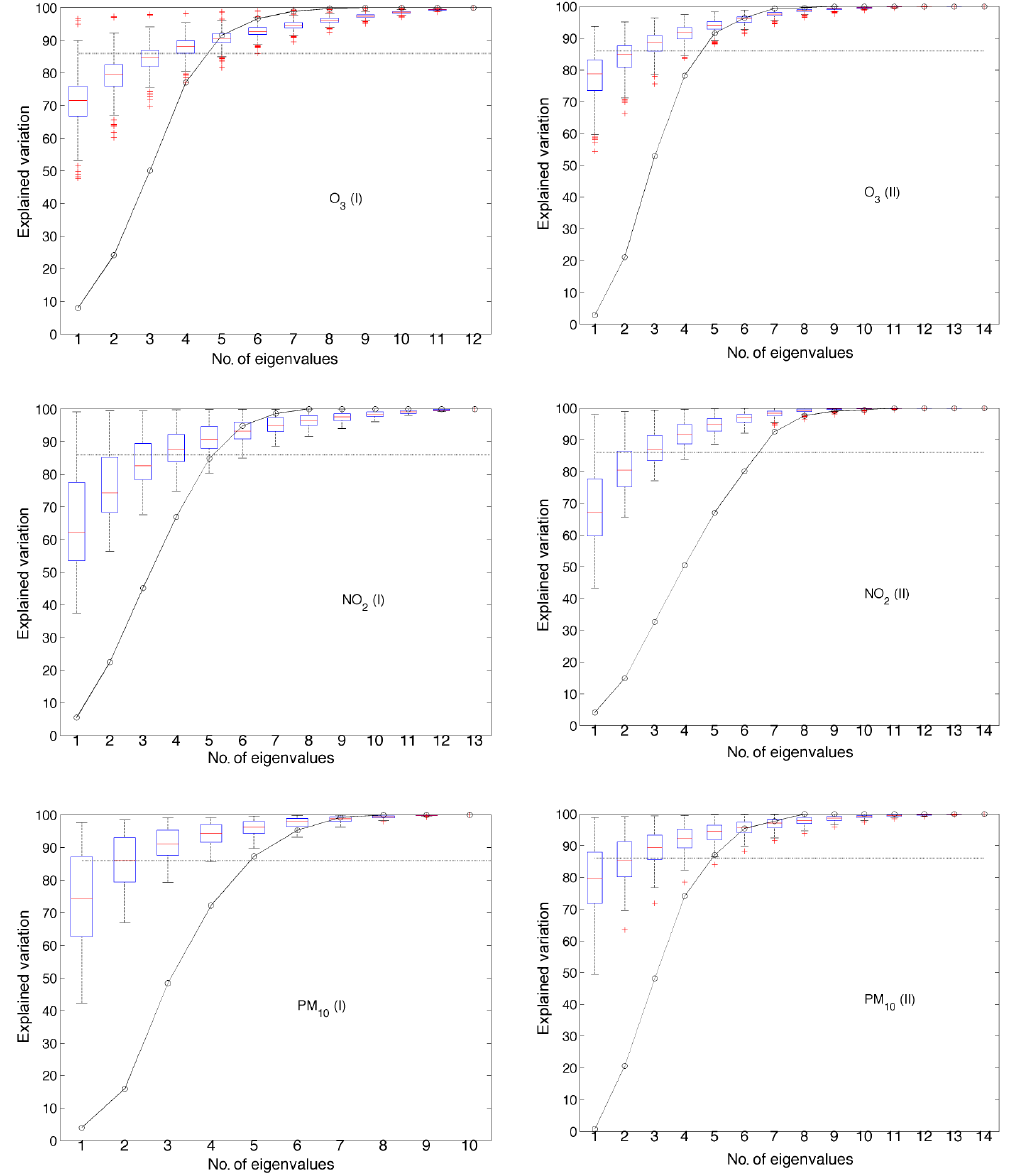
Figure 4. Model error dependence through the eigenvalues spectrum. The average explained variation from the maximum eigenvalue is 71 and 78 (phase I and II) for O 3 , 65 and 69 for NO 2 and 74 and 79 for PM 10 . On the same graph, the cumulative density function of N EFF calculated from all possible ensemble combinations is presented with the black